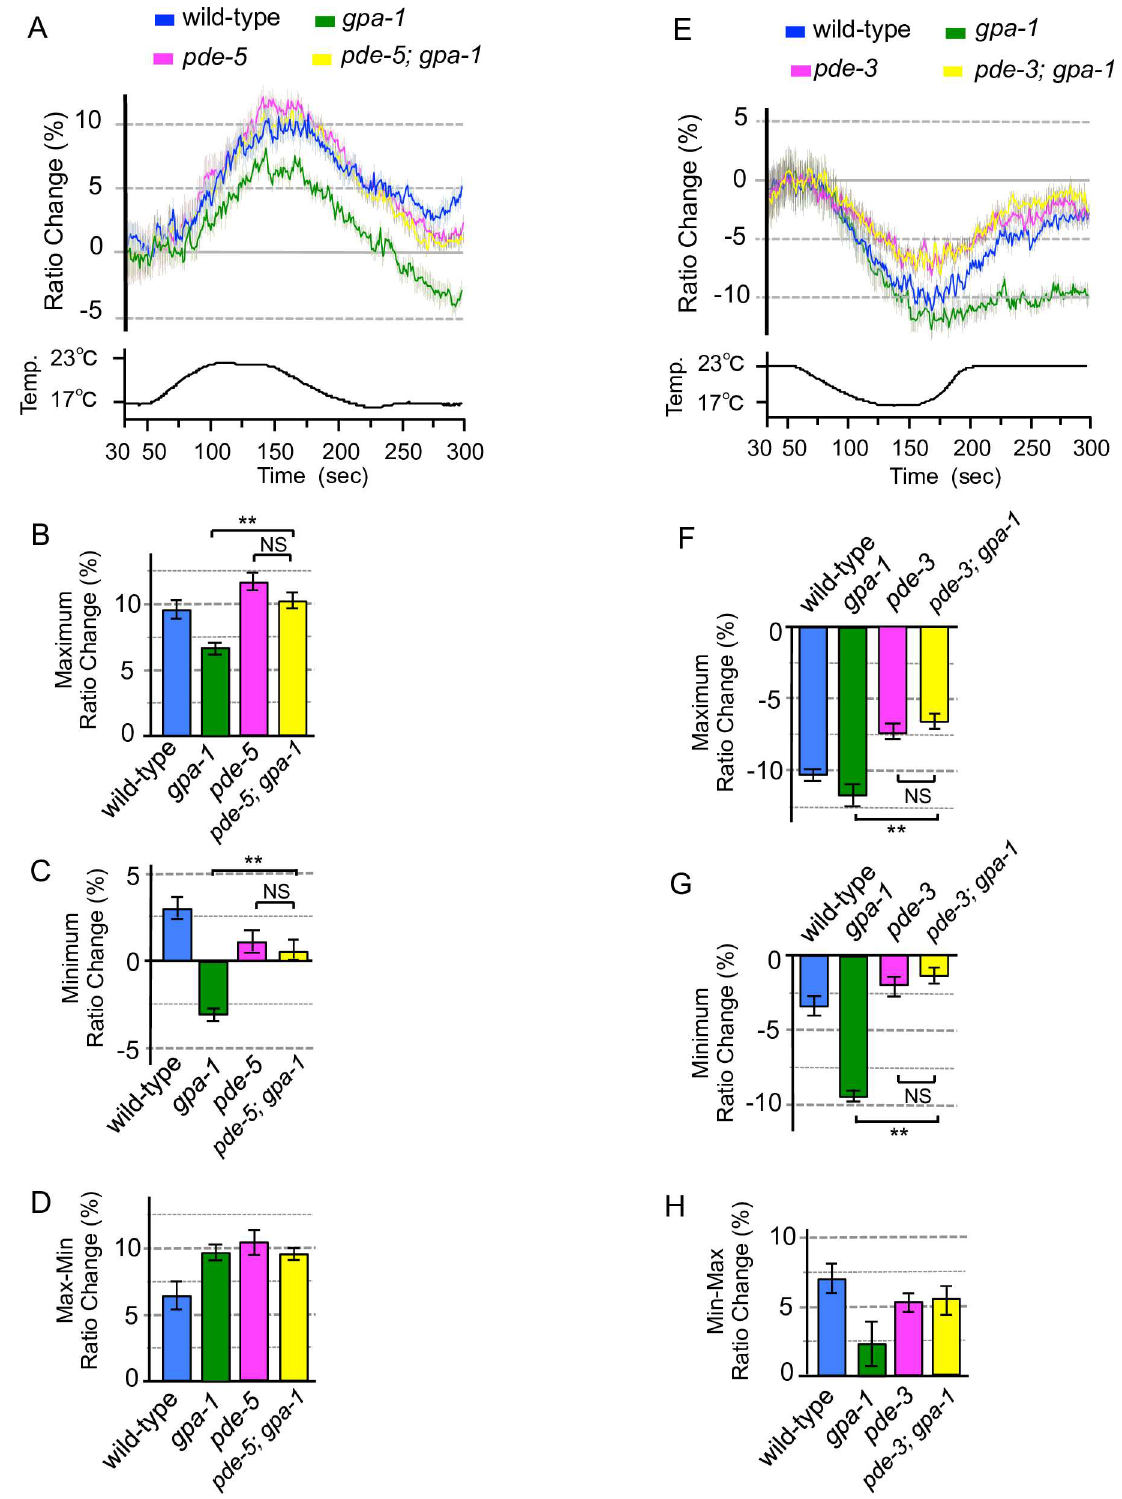
Fig 7. Genetic epistasis between PDE and G α mutations on temperature signaling. ASJ specificallyexpressingYC3.60 in wild-type worms and G α or/and PDE mutants. (A) we measured relative calcium concentrations under warming stimuli. The blue, green, and magenta lines indicate calcium concentration changes in wild-typeanimals, gpa-1 and pde-5